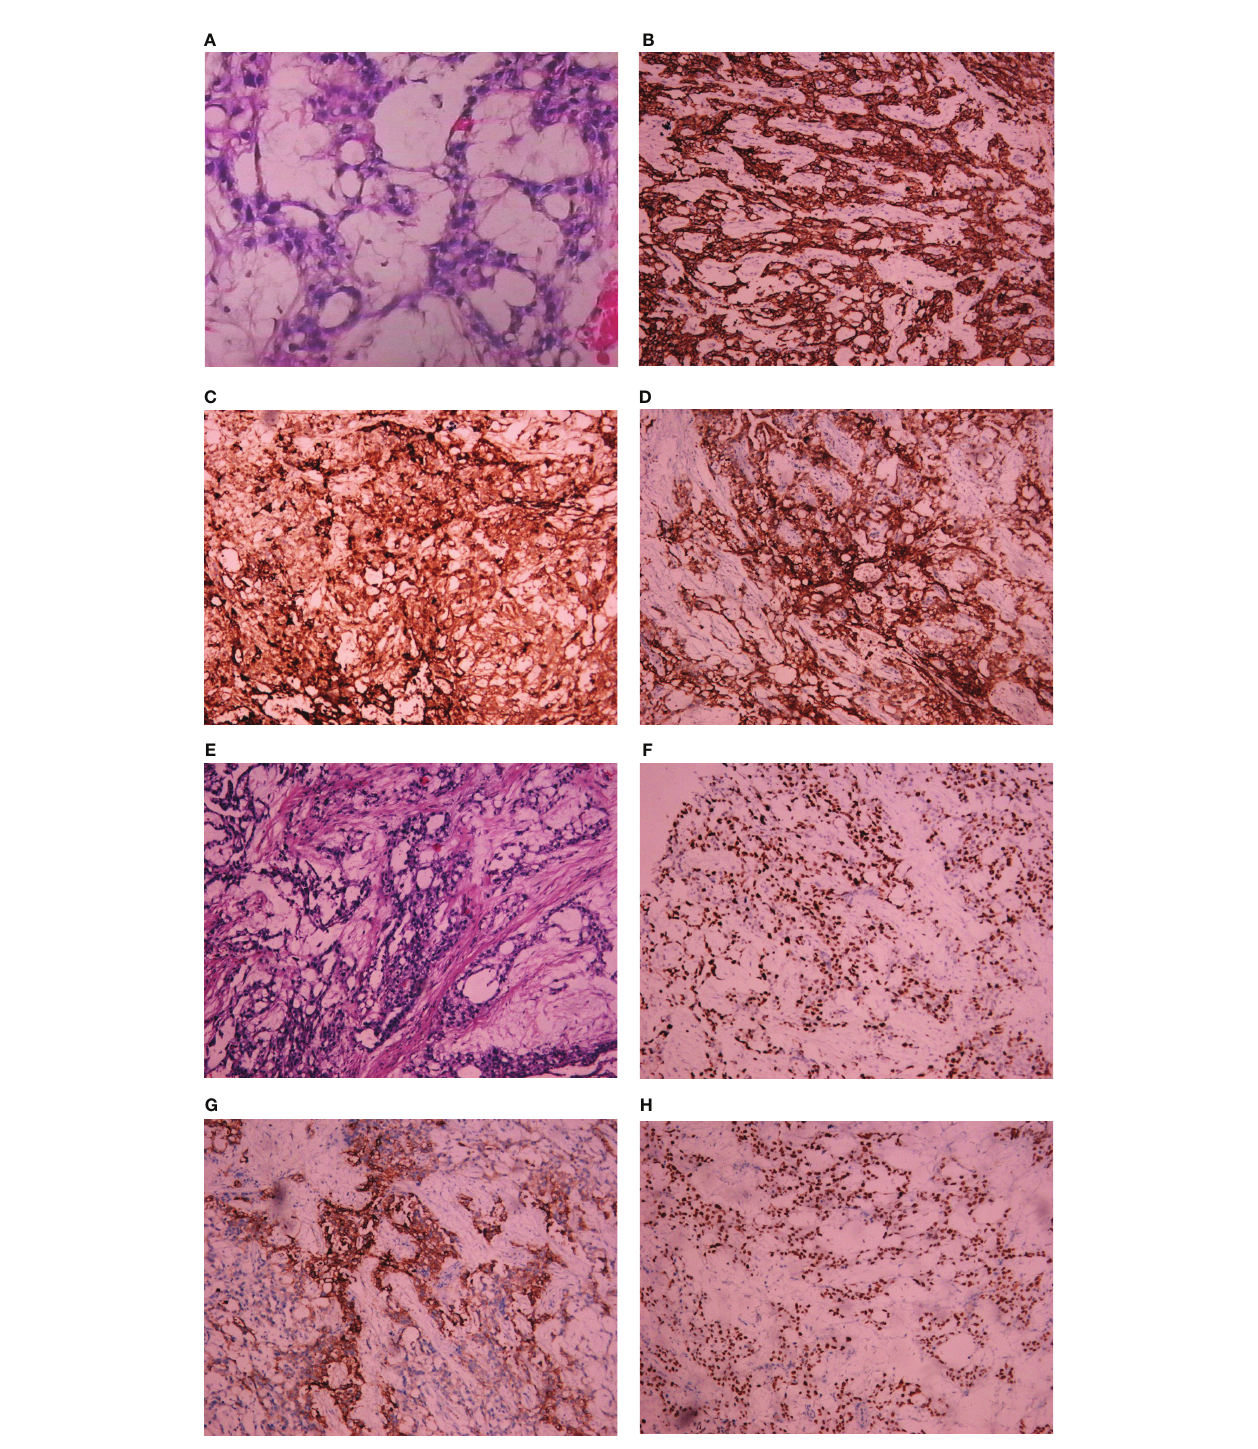
FIGURE 4 | Light microscopic appearance and immunohistochemical staining of YST originating from the broad ligament. (A) Yolk sac tumor (H and E, 10 × 40); (B) AE1/AE3+; (C) AFP++; (D) GPC-3(++); (E) Yolk sac tumor (H and E, 10 × 40); (F) Ki-67 positivity rate of approximately 70%; (G) PLAP negative; (H) SALL4